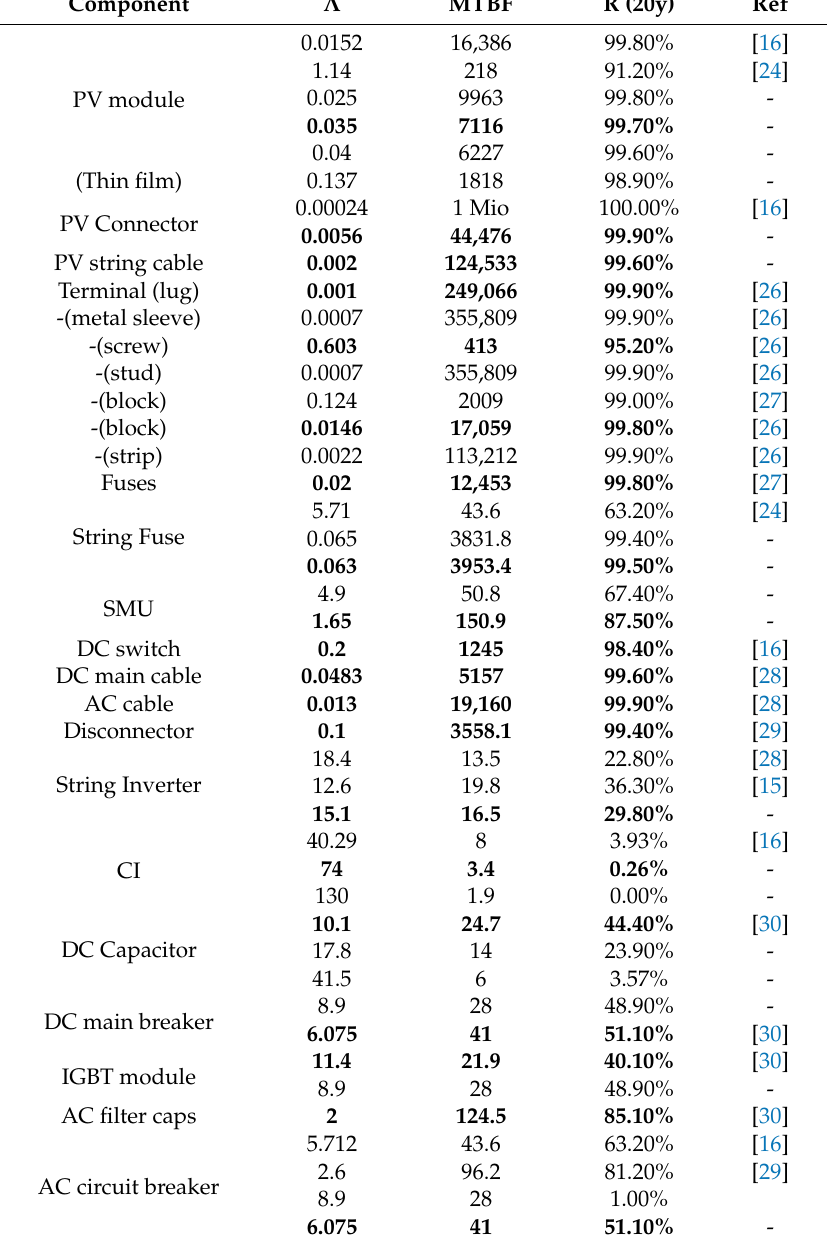
Table 1. Failure rate λ (failures per 10 6 h), MTBF in years assuming 4015 h of operation per year, reliability after 20 years and literature reference for each system component (where available). [ − ] are extrapolated values determined from juwi’s O&M reports (as taken from different power plants). Bold figures are the selected values, which are used in this